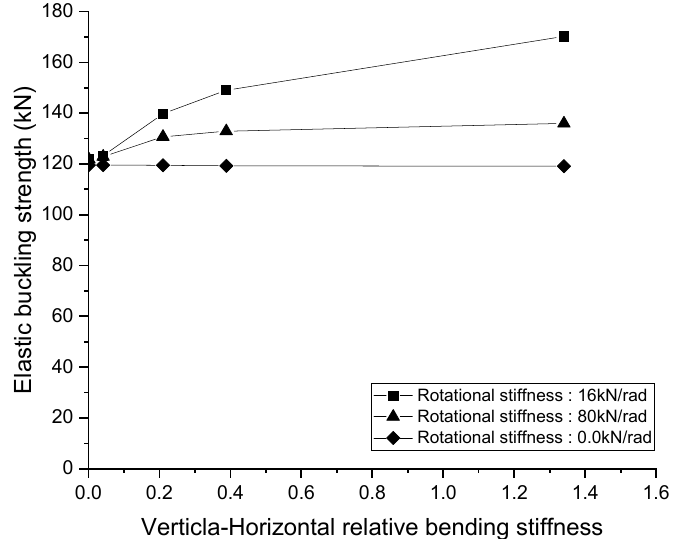
Figure 16. Elastic buckling strength according to bending stiffness (three-story, braced model).